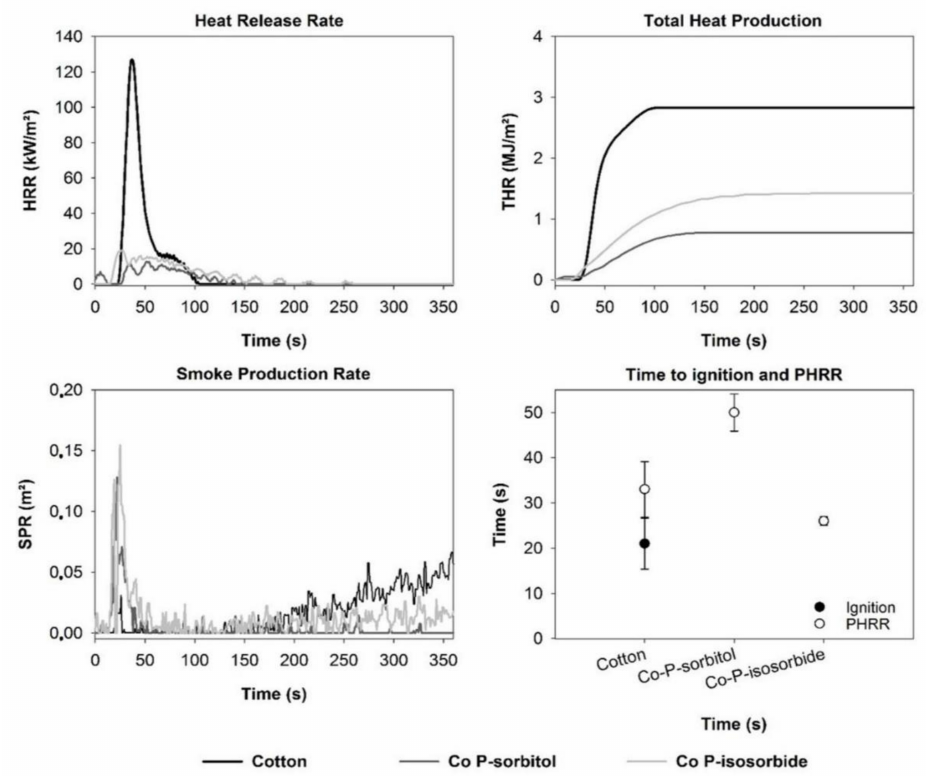
Figure 7. Cone calorimetry data of cotton (black), Co-P-sorbitol (dark grey) or Co-P-isosorbide (light